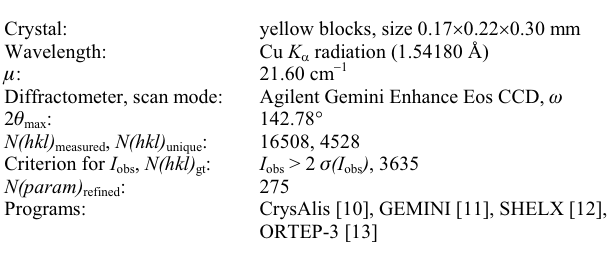
Table 1. Data collection and